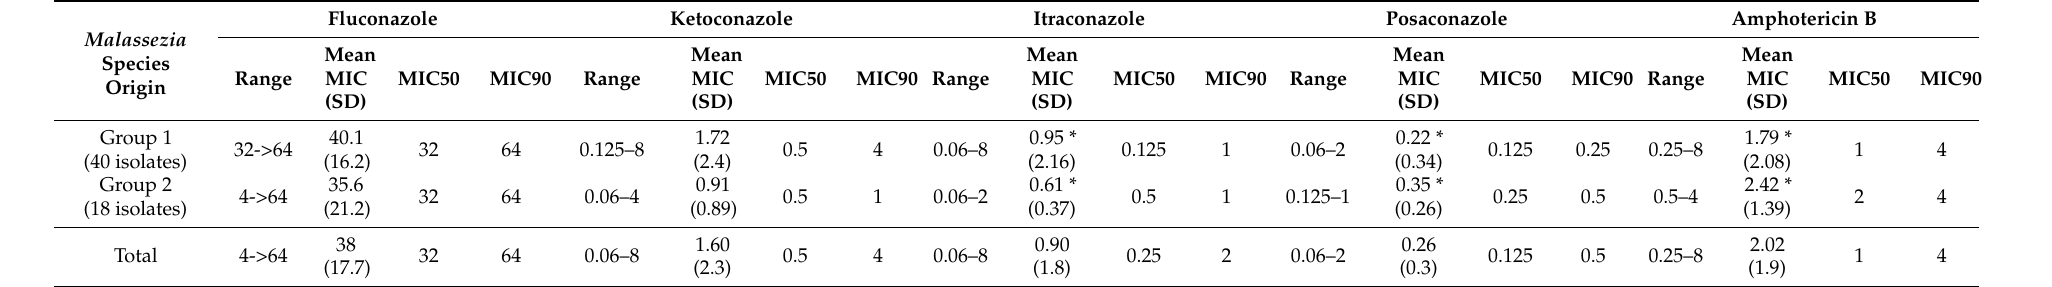
Table 1. Fluconazole (FLZ), ketoconazole (KTC), itraconazole (ITZ), posaconazole (POS), and amphotericin B (AMB) minimum inhibitory concentration (MIC,